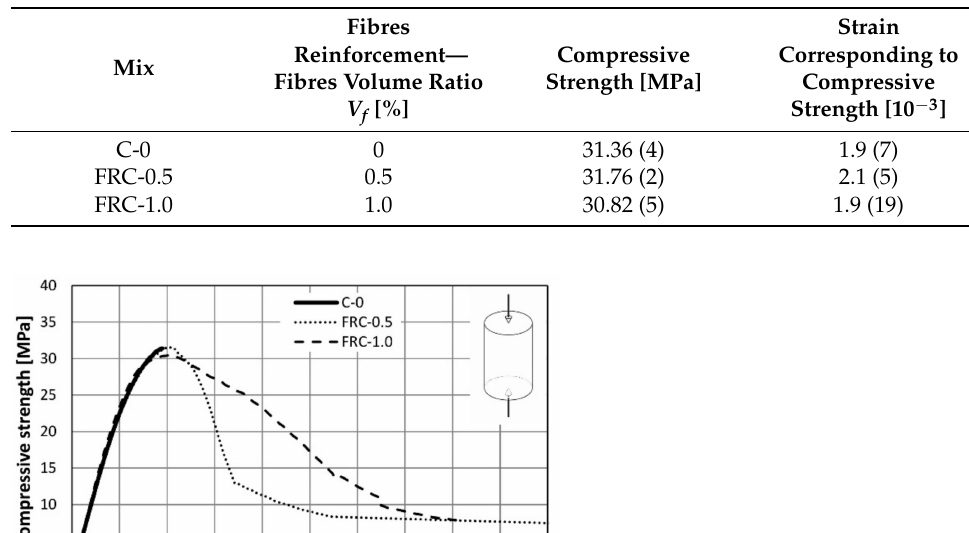
Table 5. Results from the compression tests.